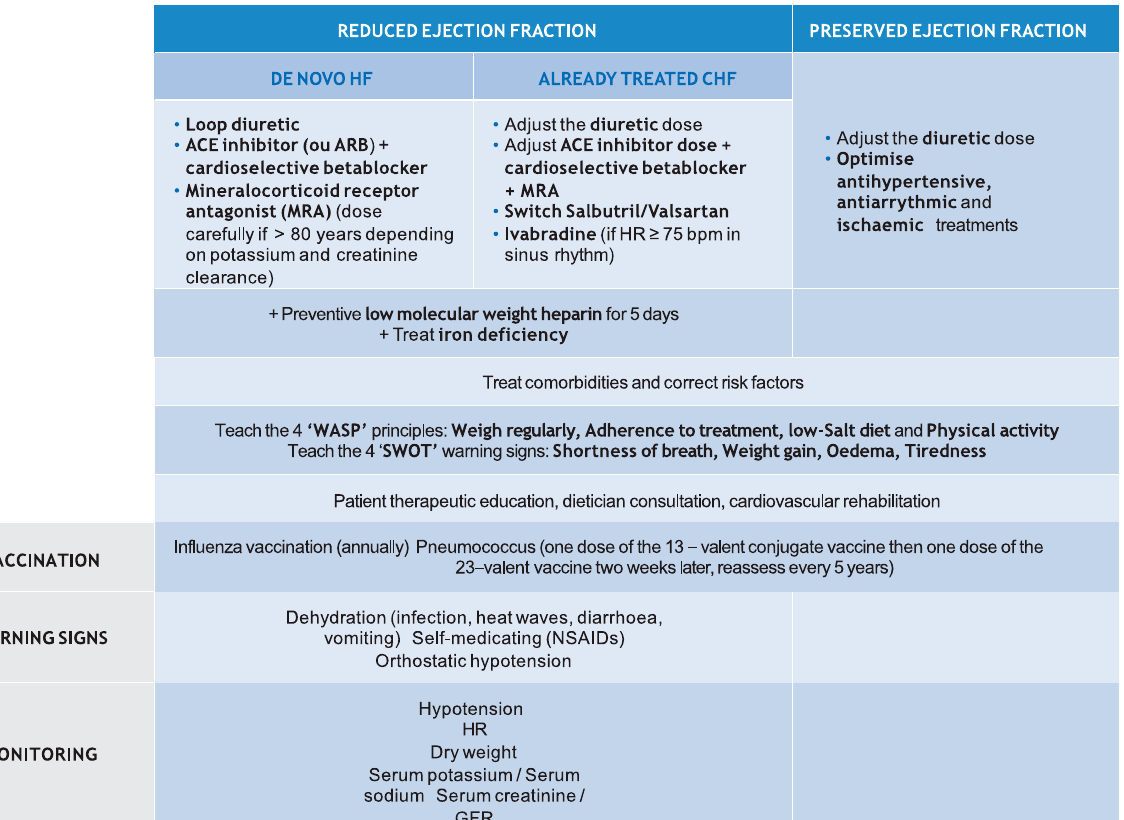
Figure 4. Therapeutic management of heart failure. This figure was developed using expert consensus, guidelines and recommendations [6,7,14,16,33,74–85].